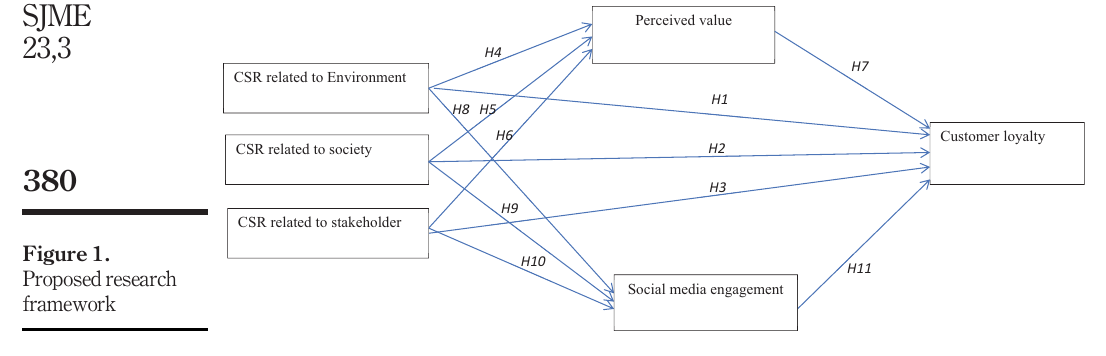
Figure 1. Proposed